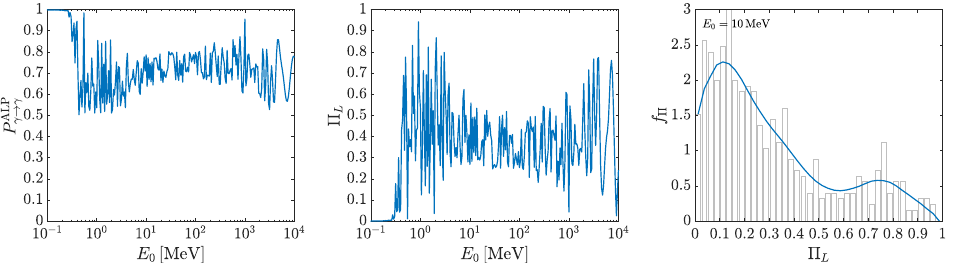
Figure 30. Photon survival probability in the presence of photon-ALP interaction P ALP γ → γ ( left panel ) and corresponding final degree of linear polarization Π L ( central panel ) with respect to the energy E 0 for photons produced in the central region of the galaxy cluster. In the ( right panel ) the probability density function f P of Π L at E 0 = 10MeV is reported. The initial degree of linear polarization is Π = 0. See the text for the system parameter L ,0